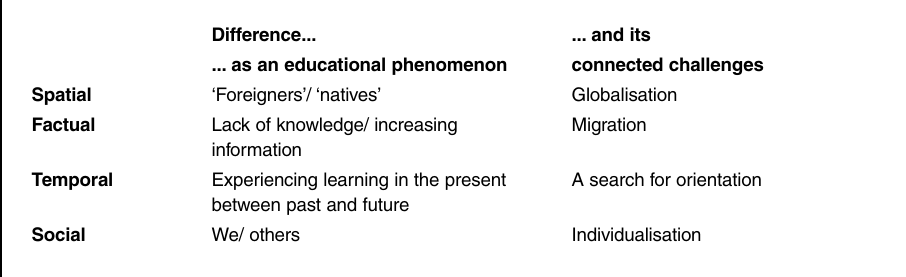
Table 1: Difference as an educational phenomenon and connected